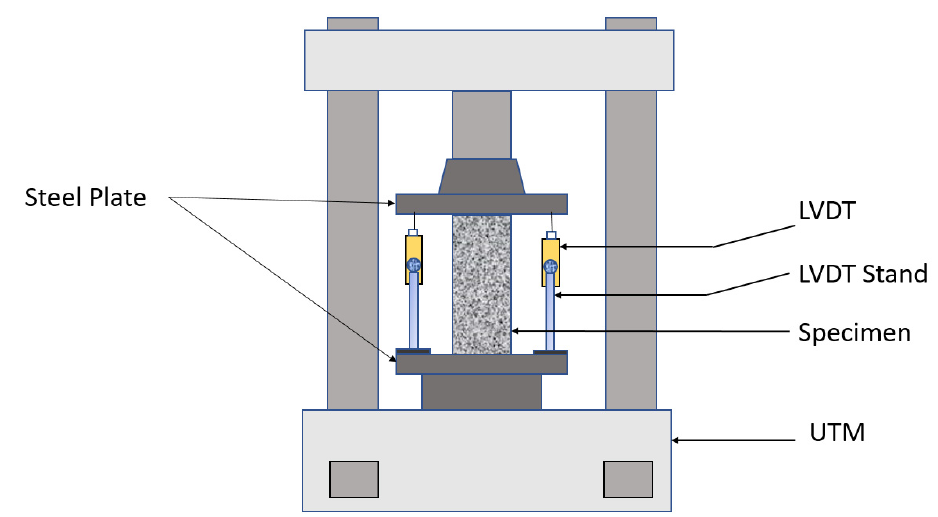
Figure 4. Schematics of the test setup.